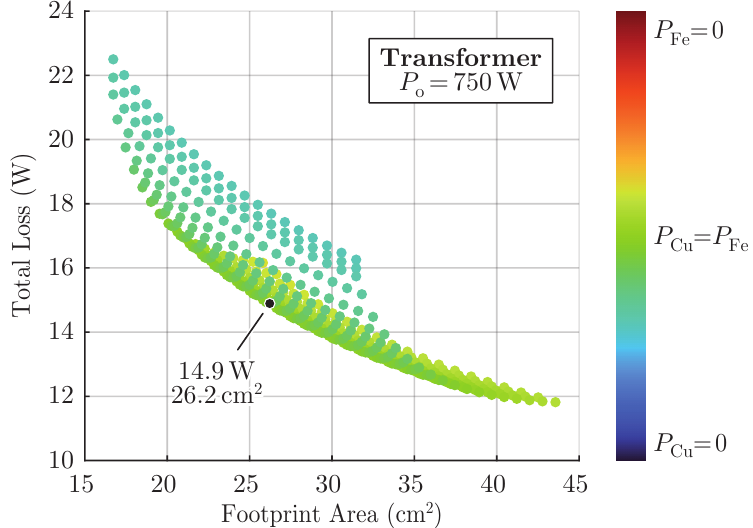
Figure 17. Transformer Pareto front optimized at 50% load by increasing limb and yoke cross- sectional areas according to case (i) of Figure 18a, which shows that 8.11W/6.59W of core/winding losses is optimal on Figure